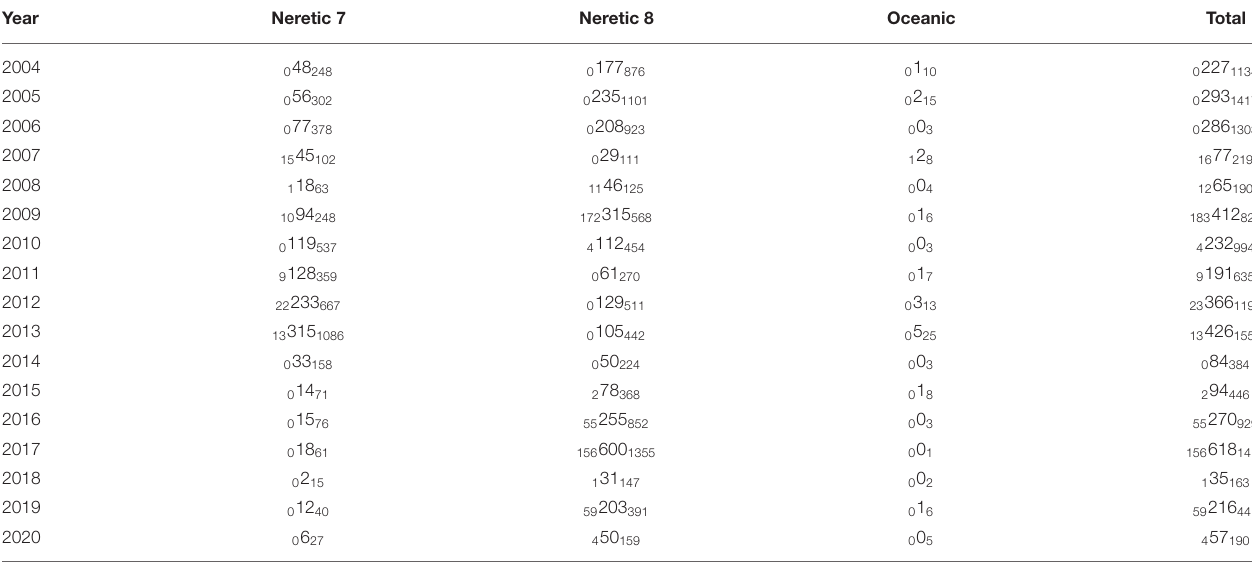
TABLE 5 | Model-based estimates of common dolphin bycaught in PTM in the study